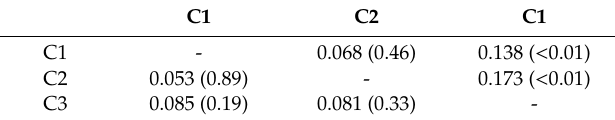
Figure 7. Histograms of height distribution of single returns for C1, C2, and C3 over LP plot ( a ), and corresponding kernel densities ( b ). Table 9. Results of Kolmogorov-Smirnov test D values ( p -value in brackets) for returns higher than 10 m above ground (in the upper-right), and returns higher than 19 m above ground (in the lower- left).